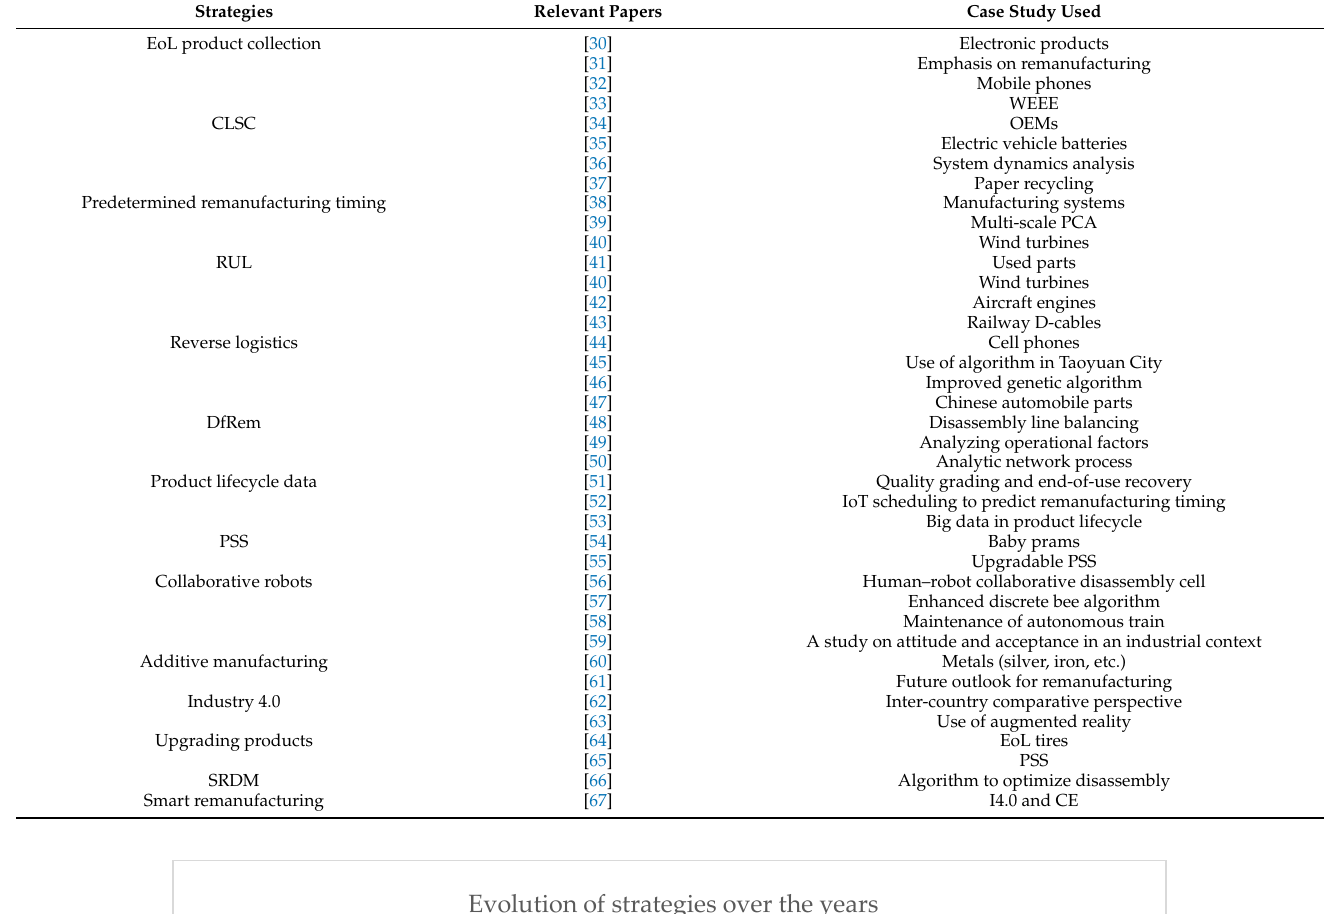
Table 1. Case studies used in various strategies.